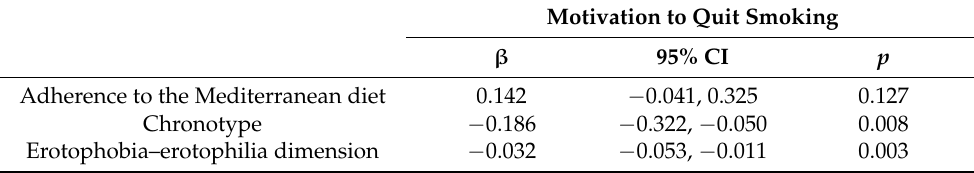
Table 3. Associations between adherence to the Mediterranean diet, chronotype, erotophobia– erotophilia dimension, and motivation to quit smoking.